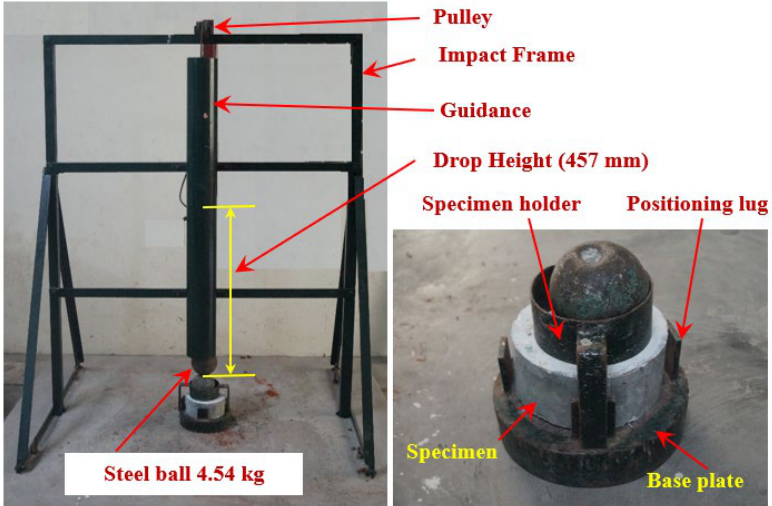
Figure 4. Test setup.